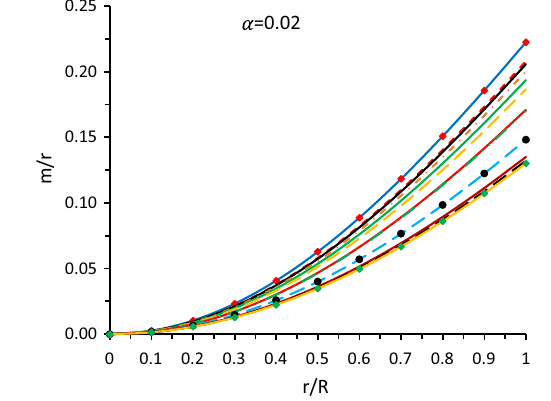
Fig. 8 The behavior of mass-radius ratio ( m / r ) versus radial coordi- nate r / R by taking the numerical values of the constants a = 0 . 003, b = 0 . 0000053, β = 1 . 1, and γ = − 0 .